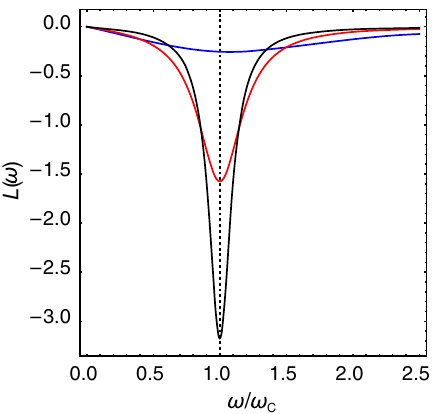
FIG. 10. The function L ð ω Þ of Eq. (52) is plotted in arbitrary units for three different values of τ . The blue line corresponds to τ ¼ 1 , the red line to τ ¼ 5 , and the black line to τ ¼ 10 , with ω ¼ 10